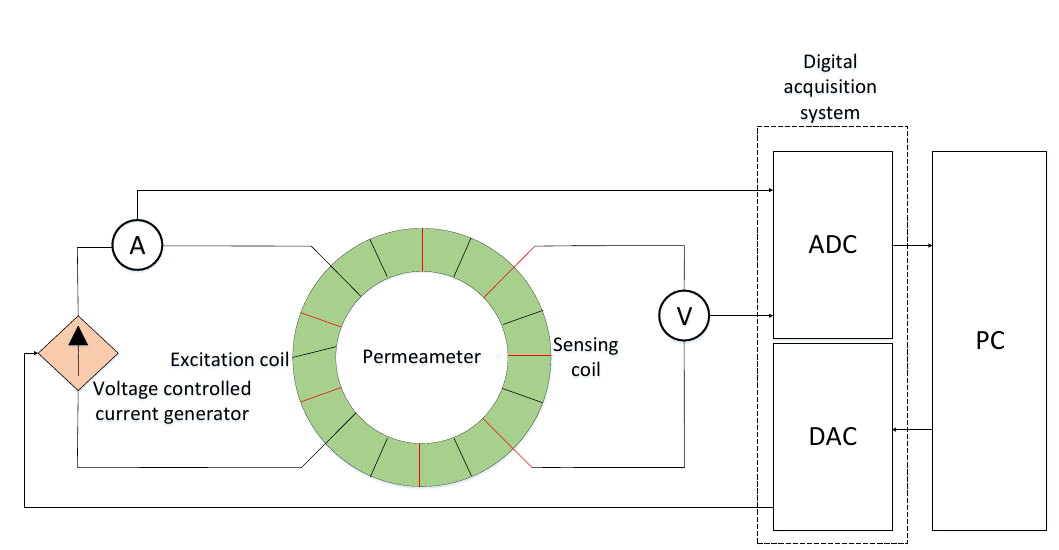
Figure 2. Measurement system